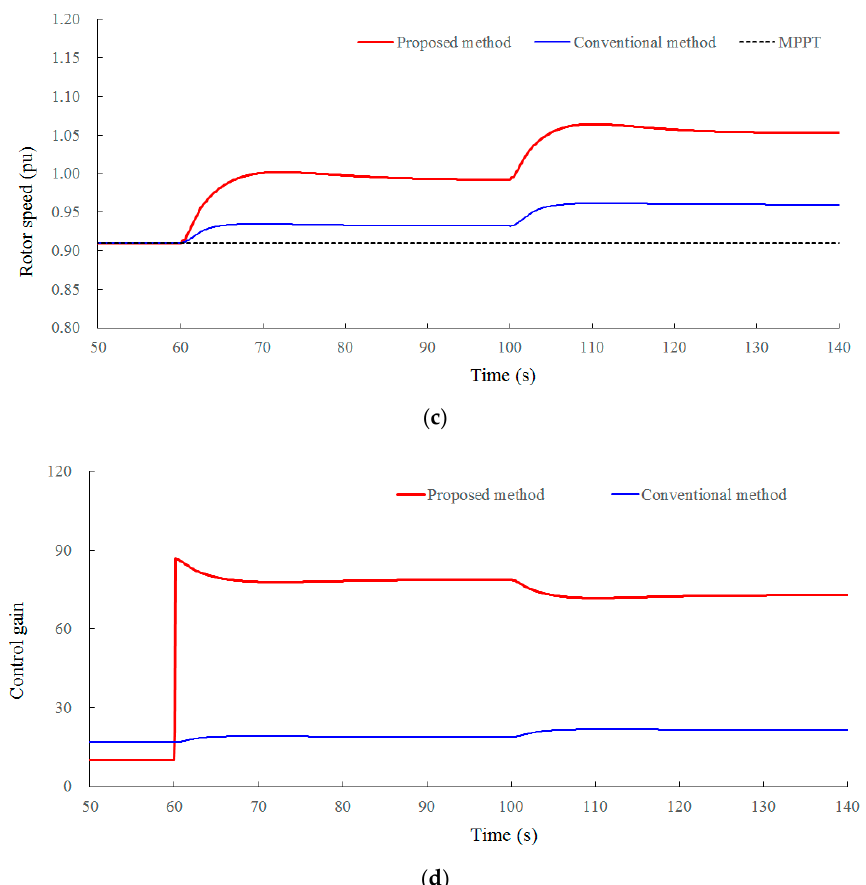
Figure 9. Simulations for Case 4: ( a ) System frequencies; ( b ) Active powers; ( c ) Rotor speeds; ( d ) Control gain.